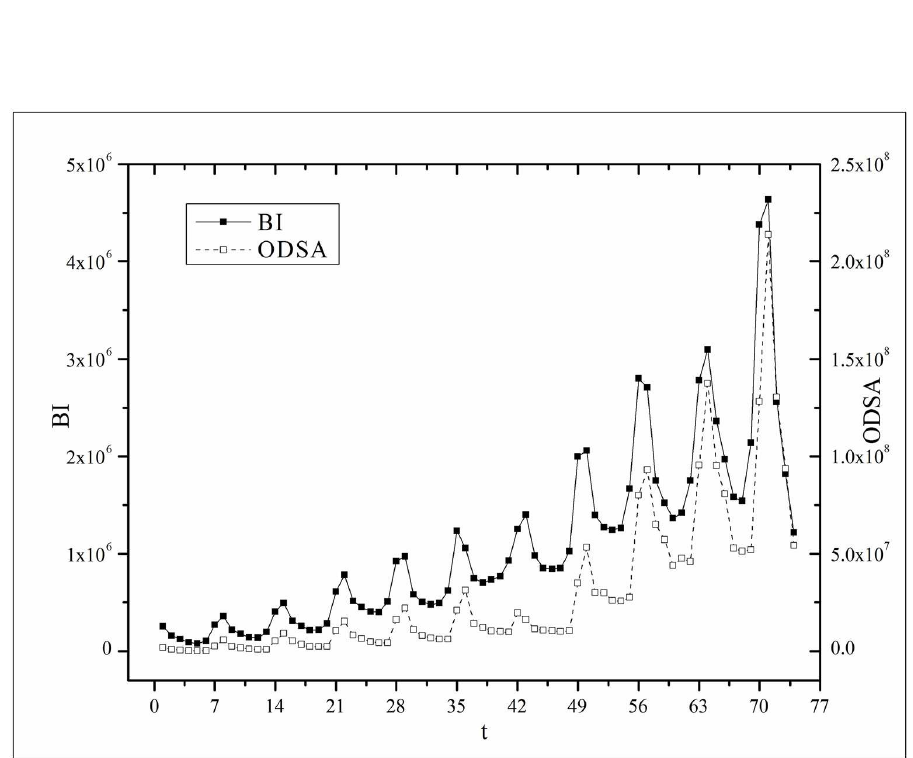
Fig 11. Correlation analysis of the Love